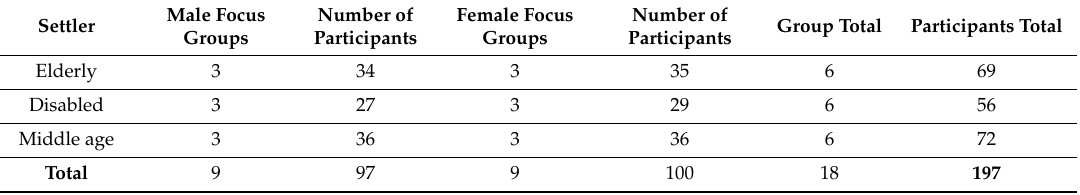
Table 2. Settler FGD participants in Kunfabiala, Piina number 2 and